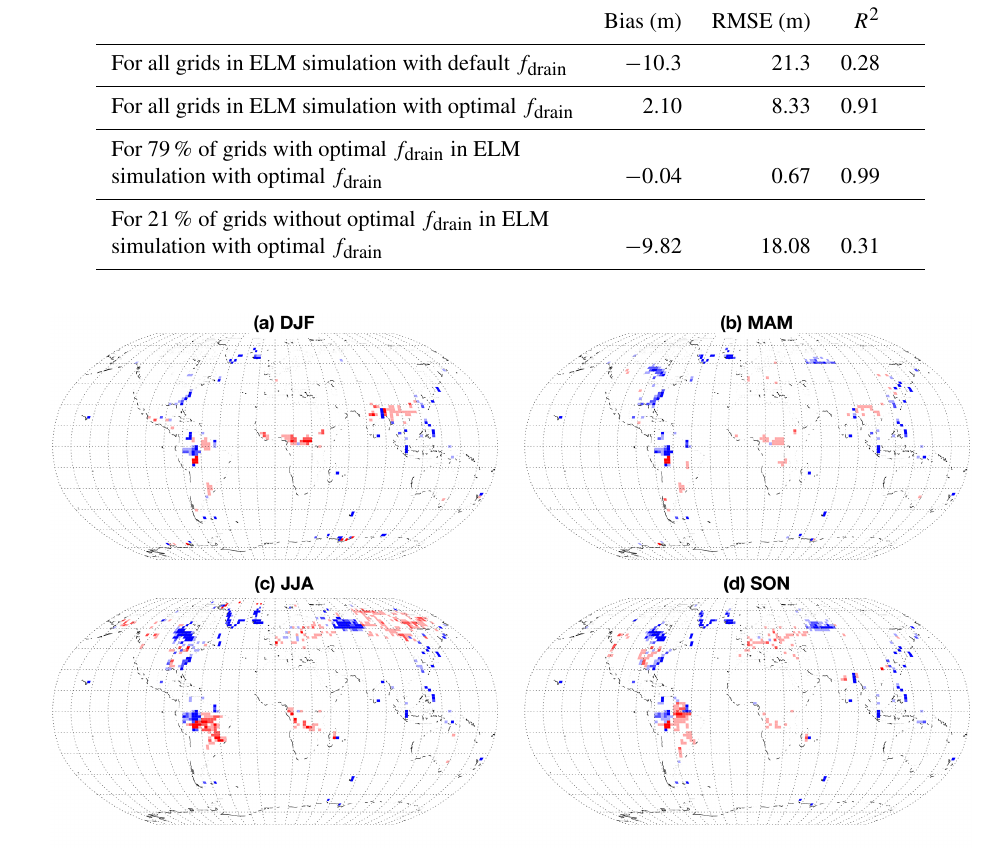
Table 2. Bias, root mean square error (RMSE), and correlation ( R 2 ) between simulated water table depth and Fan et al. (2013) data.